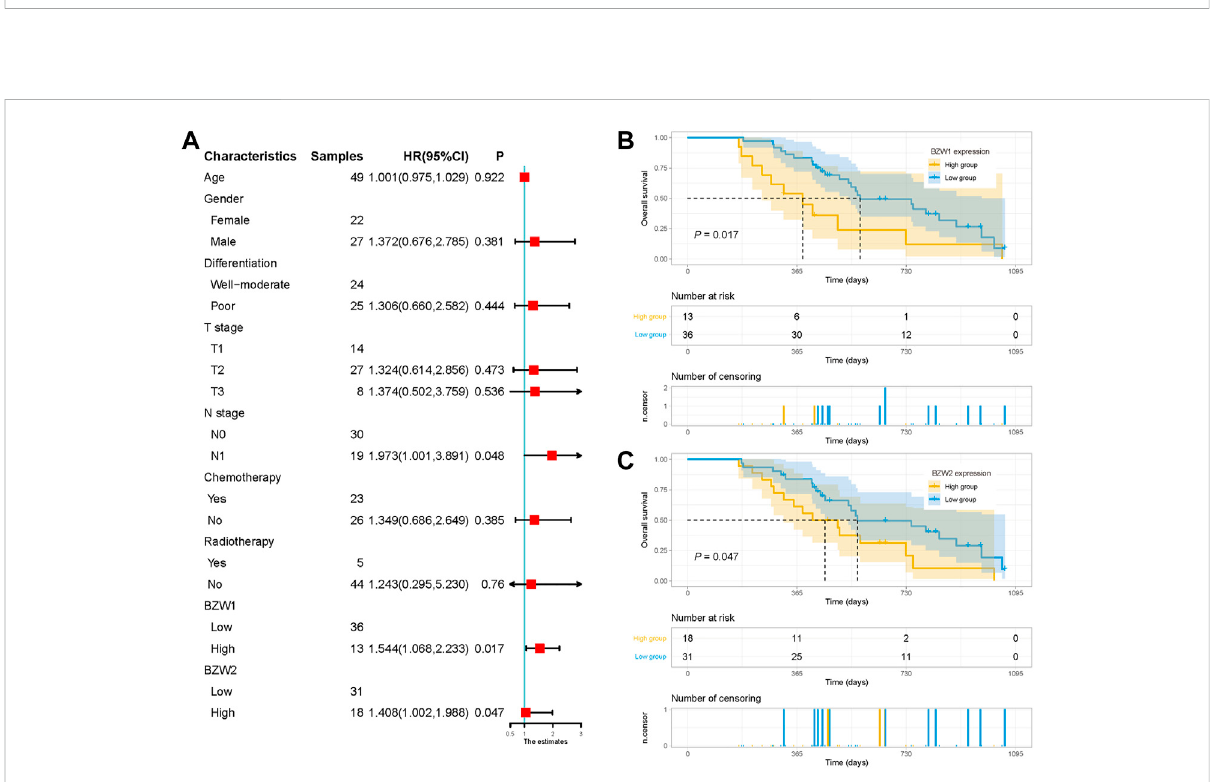
FIGURE 10 (A) Univariate analysis of OS in the external validation cohort. Survival curves for BZW1 (B) expression and BZW2 (C) expression in the external validation